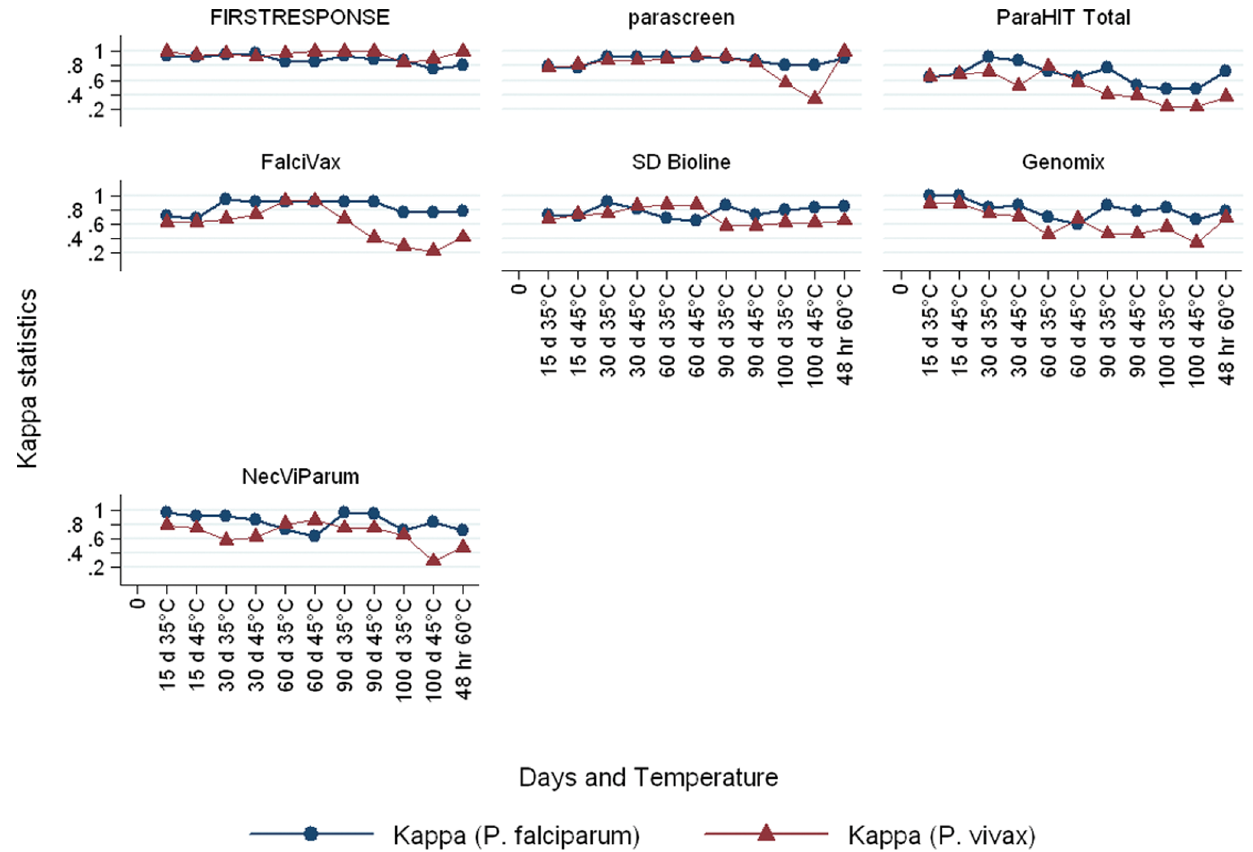
Figure 3. Kappa statistics of measure of agreement at temperature 35 6 C, 45 6 C and 60 6 C against room temperature for P.falciparum and P.vivax of seven difference